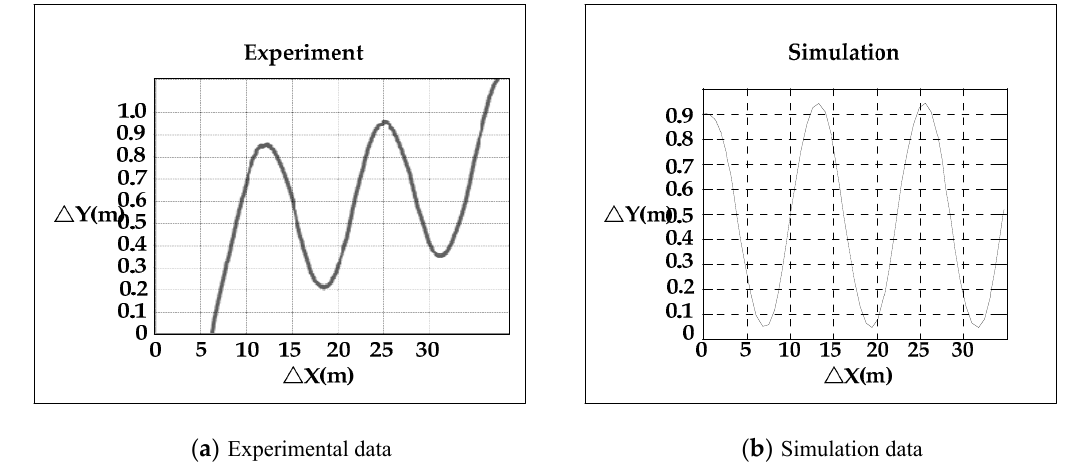
Figure 8 . +10 deg zig-zag test: comparisons between simulated and experimental data.